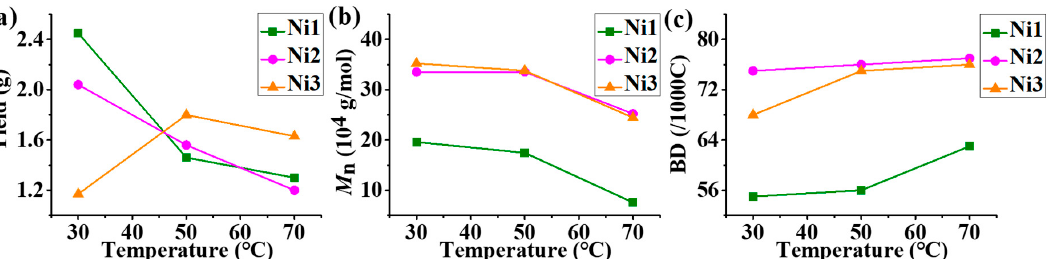
Table 1. Ethylene Polymerization a .